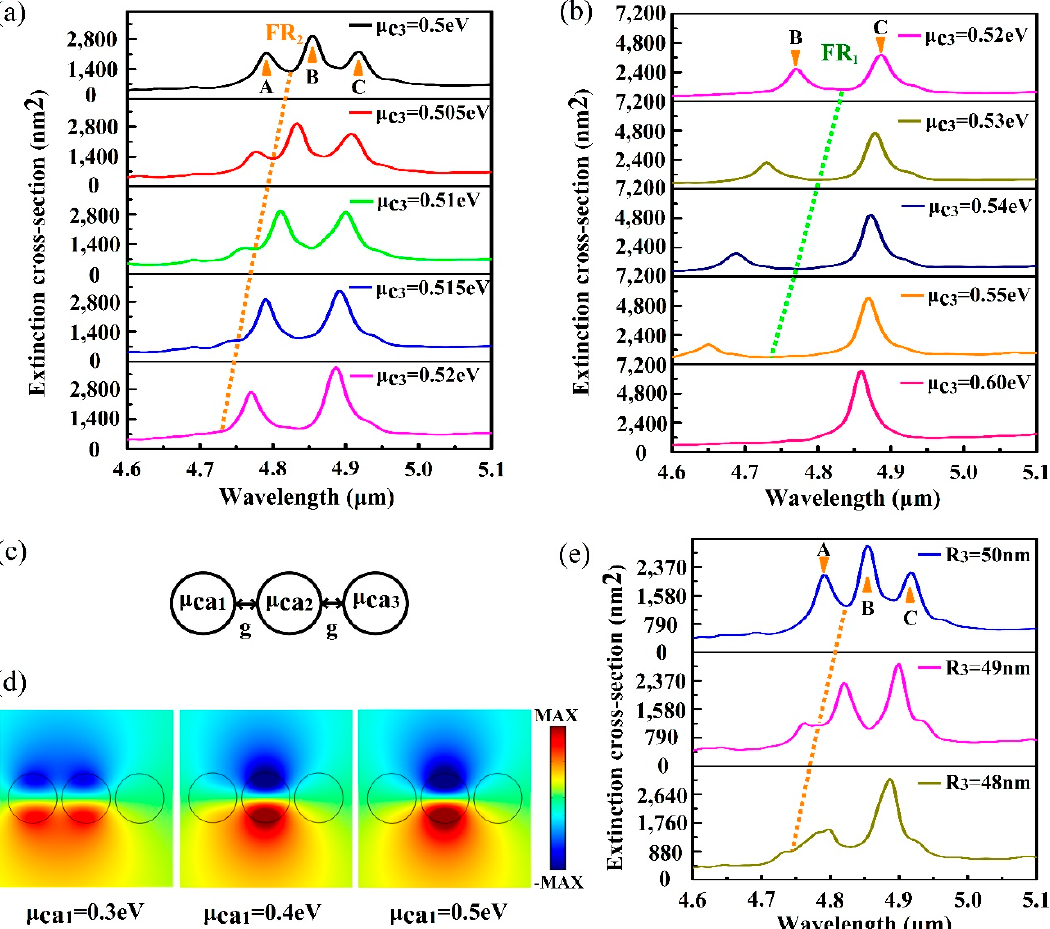
Figure 3. ( a ) Extinction spectra with the increase of µ c 3 ranged from 0.5 eV to 0.52 eV. ( b ) Extinction spectra with the increase of µ c 3 ranged from 0.52 eV to 0.6 eV. ( c ) Schematic of the graphene trimer nanostructure. ( d ) The near-field distributions with the variation of µ ca 1 . ( e ) Extinction spectra with the change of radius R 3 .